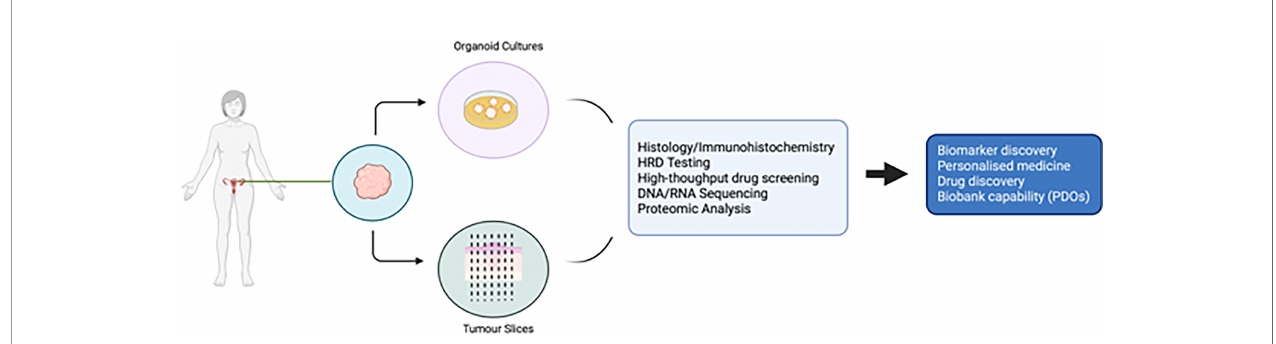
FIGURE 1 | Potential uses of patient derived organoids and tumour slices in ovarian cancer research.